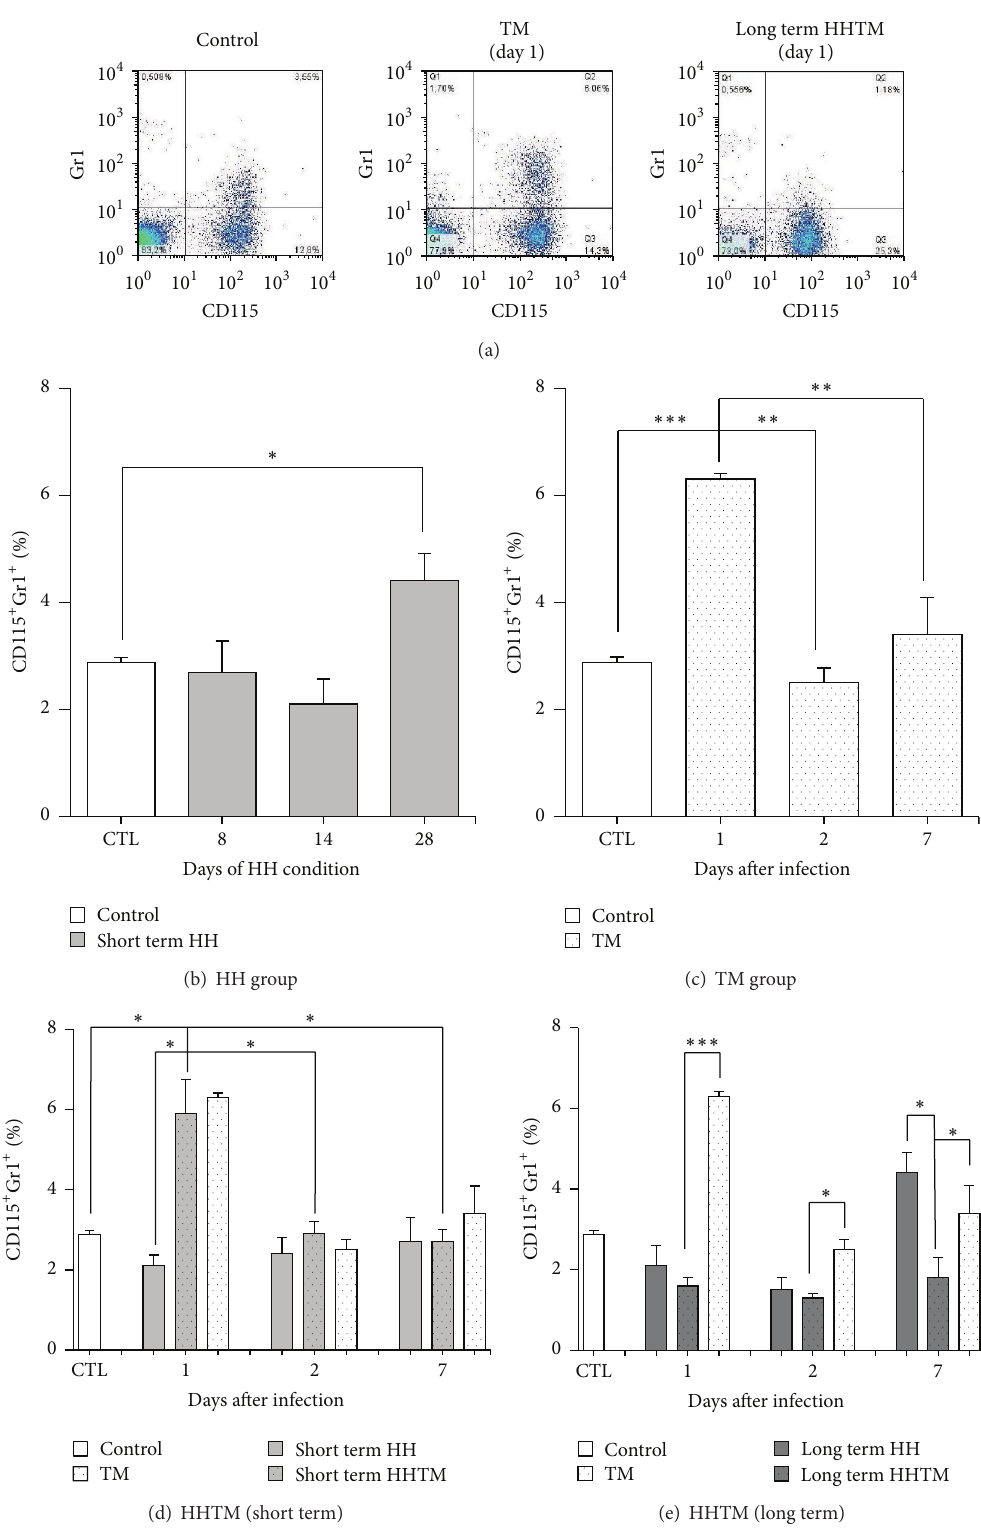
Figure 3: The distribution of peripheral blood monocyte subsets in TM-infected mice and noninfected HH mice. (a) Representative flow cytometry dot plot of data acquisition showing CD115 and Gr1 surface expression on peripheral blood cells. The numbers in the dot plots represent the percentages of each cell population within the square. (b) The distribution of inflammatory CD115 + Gr1 + monocytes in the HH group. Peripheral blood cells were analyzed from 8 to 28 days after HH induction. (c) The distribution of inflammatory CD115 + Gr1 + monocytesintheTMgroup.Peripheralbloodcellswereanalyzedat1,2,and7daysafterfungalchallenge.(d)Thedistributionofinflammatory CD115 + Gr1 + monocytesintheshorttermHHTMgroup.(e)ThedistributionofinflammatoryCD115 + Gr1 + monocytesinthelongtermHHTM group. Data are expressed as the mean ± SEM of percentages and are representative of two independent experiments ( 𝑛 = 6 mice/group). Multiple comparisons of means were performed using ANOVA with the Tukey post hoc test ( ∗ 𝑝 ≤ 0.05